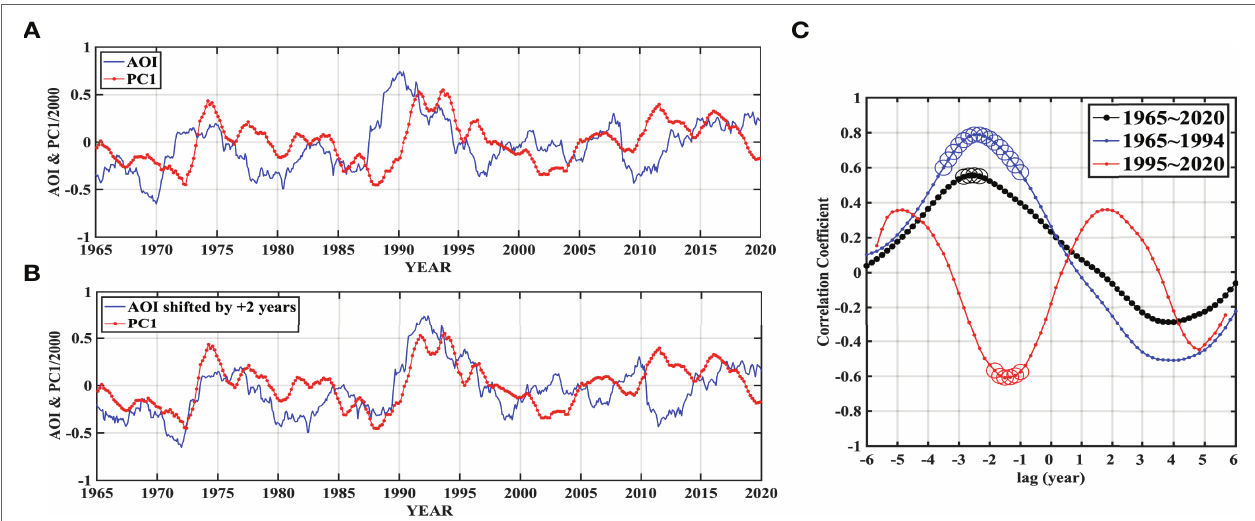
FIGURE 13 | (A) Time series of 3-year moving-averaged AOI (blue) and the EOF first mode PC of the ESIW thickness scaled by 1/2,000 (red). (B) Same as panel (A) but AOI shifted by 2 years and (C) lagged-correlation diagram between AOI and first mode PC of the ESIW thickness. The black line is from the whole data. The blue line is from the data of 1965−1994 and the red one is of 1995−2020. The open circles denote where the correlations are above 95% significance